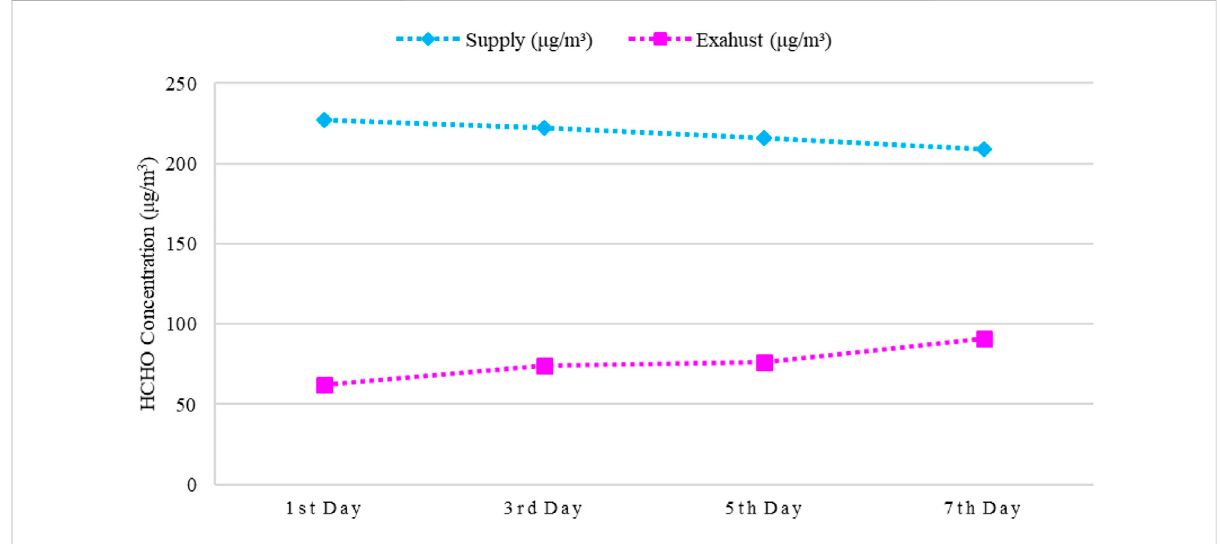
FIGURE 4 HCHO Adsorption Test Result (Normal wallpaper with 5 wt%).